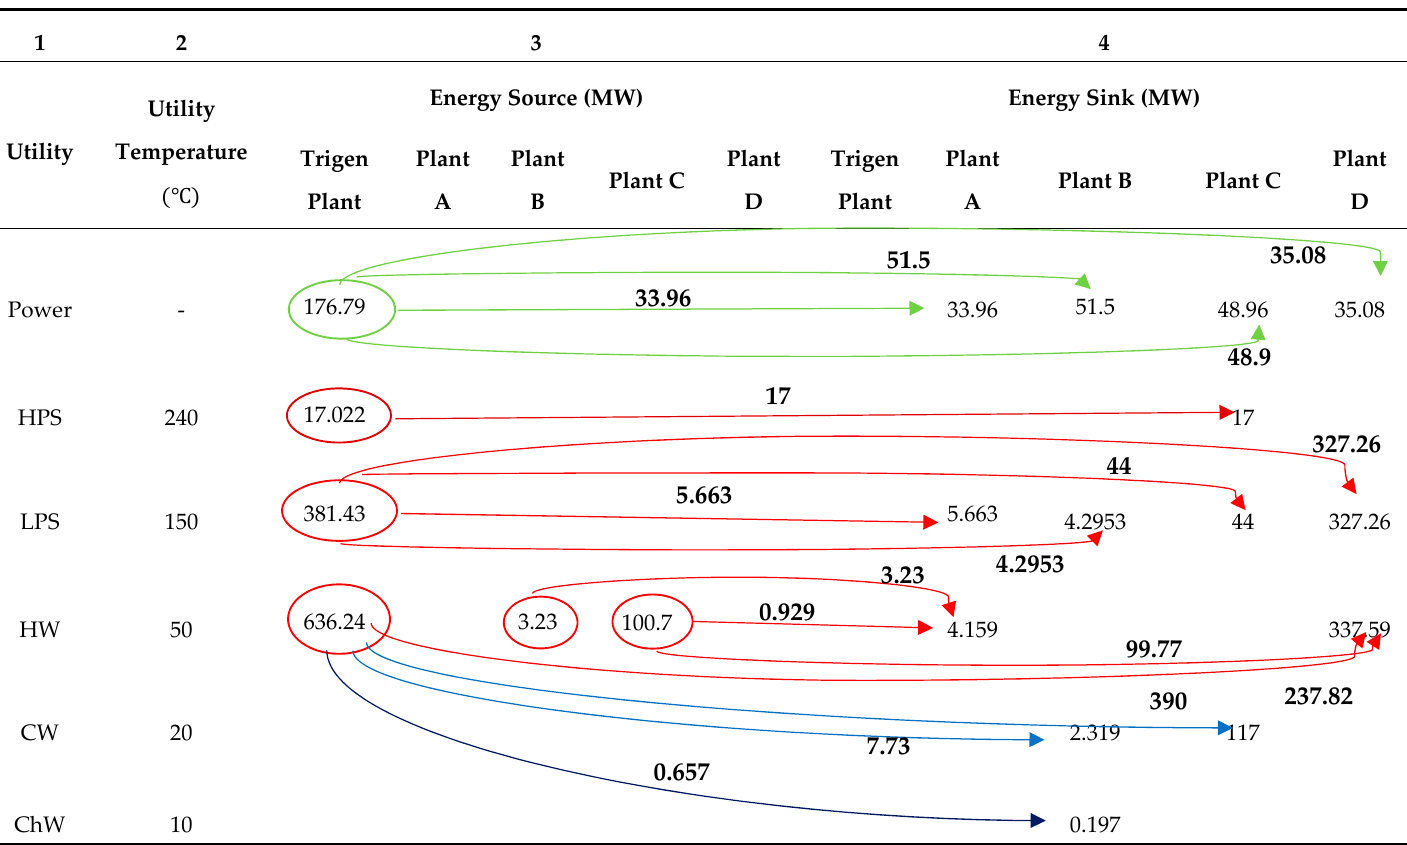
Table 9. Total Site Utility Distribution (TSUD).